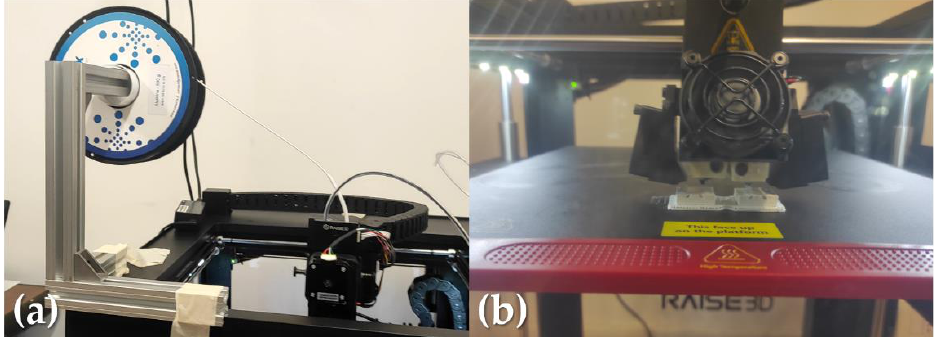
Figure 1. FFF printer: ( a ) direct feeding system, ( b ) building area.